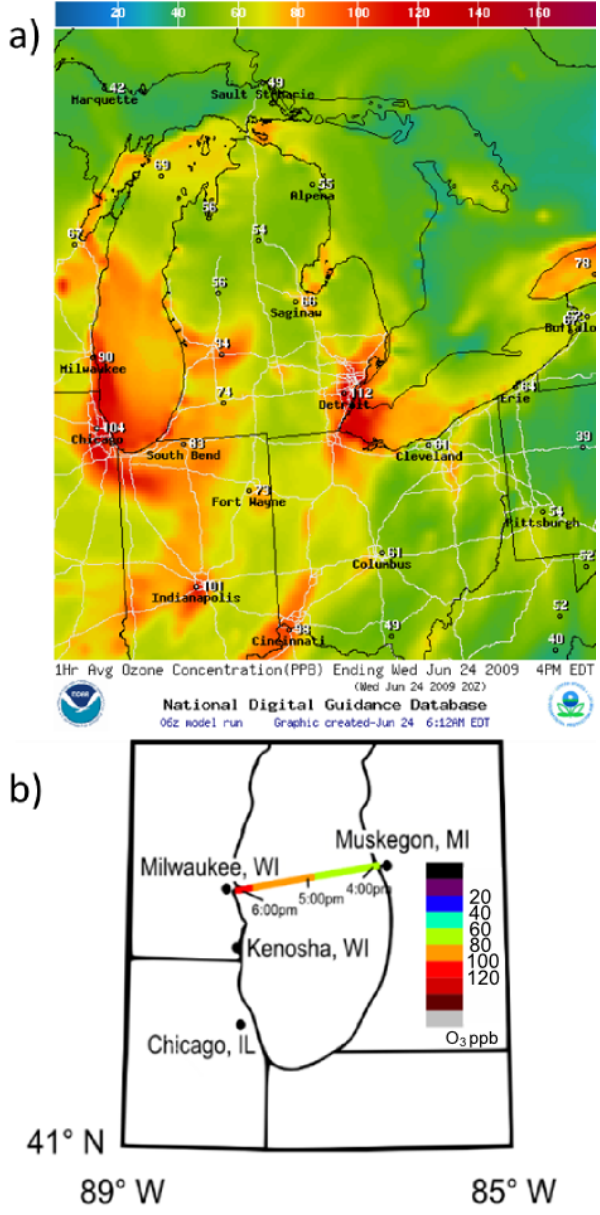
Figure 8. (a) Sample image of National Air Quality Forecast Model (NAQFM) during the campaign period, (b) O 3 measurements for one ferry trip on 24 June 2009 where the ferry was in transit from 15:50 to